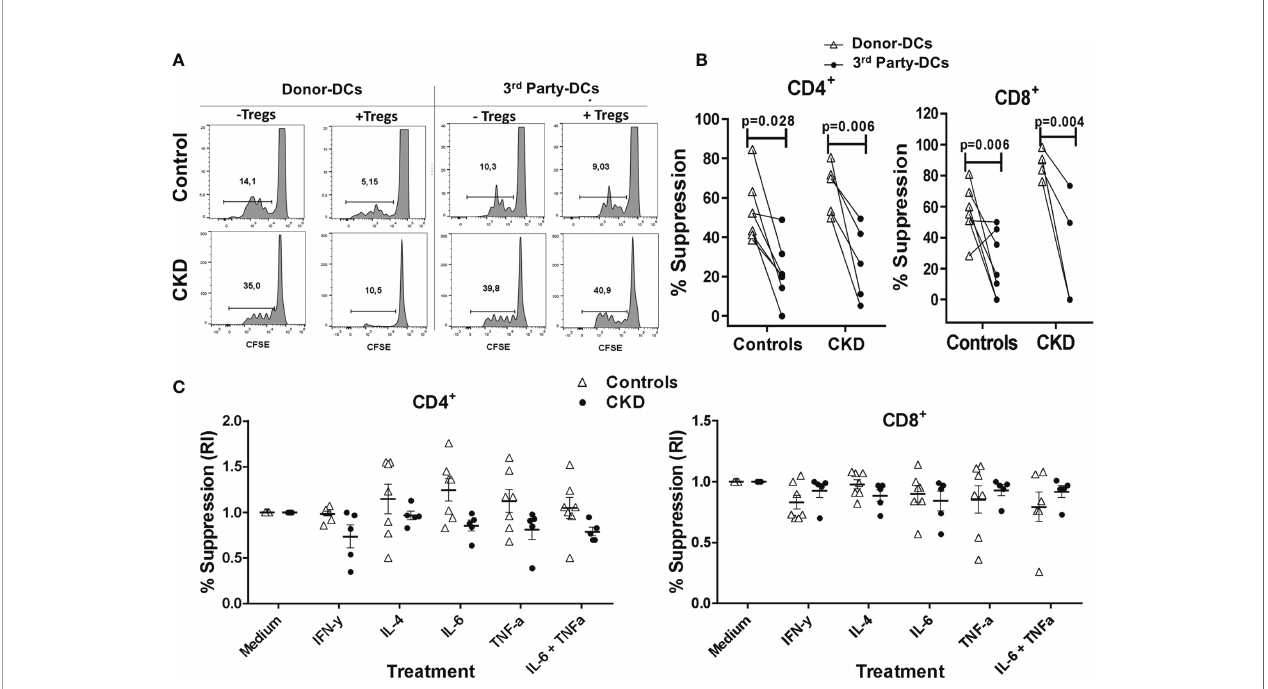
FIGURE 4 | Expanded allospeci fi c regulatory T cells (Tregs) suppressed the proliferation of conventional T cells in an alloantigen-speci fi c manner. Expanded allospeci fi c Tregs ( allo Tregs) from healthy individuals ( white triangles , n = 7) or patients with chronic kidney disease (CKD) ( black circles , n = 5) were co-cultured with conventional CD3 + T cells [labeled with carboxy fl uorescein succinimidyl ester (CFSE)] and stimulated with allogeneic monocyte-derived dendritic cells (Mo-DCs) from their respective donors or from non-related individuals (third party). On day 4 of culture, T-cell proliferation was evaluated by fl ow cytometry. (A) Representative experiment. (B) Expanded allo Tregs suppressed the proliferation of both CD8 + and CD4 + conventional T cells (Tconv) only when they were stimulated with the dendritic cells (DCs) with which they were initially expanded (DCs from donor), but not when they were stimulated with unrelated DCs (third party). (C) allo Tregs ef fi ciently suppressed alloreactive T cells in the presence of the in fl ammatory cytokines IFN- g , IL-4, IL-6, and TNF- a (C) . The relative increase (IR) of the percentage of suppression was calculated by dividing the value in the presence of the cytokine by the value in the absence of cytokine (medium). All experiments were performed in duplicate. The results are shown as the mean ± SEM. Statistical analysis was performed using unpaired t -test (B) or one-way ANOVA (B)